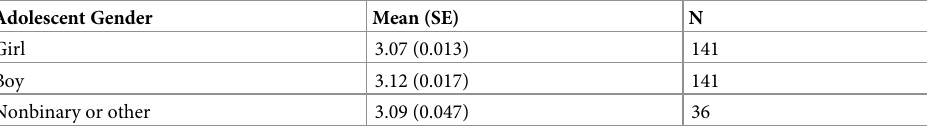
Table 9. Adolescent stereotype endorsement: Means, standard errors, and N’s by adolescent gender.